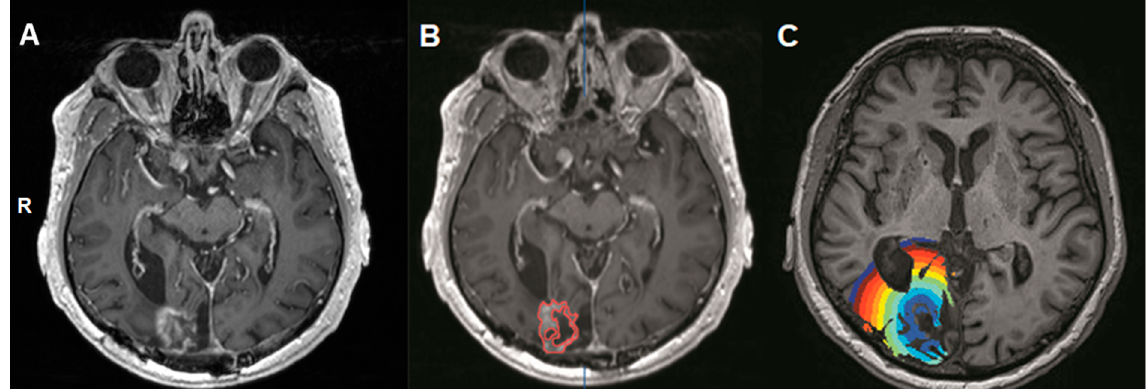
Figure 1. Illustration of the volumes-of-interest (VOIs). A contrast-enhanced axial T1-weighted morphological MRI scan of a patient with a right occipital contrast-enhancing lesion fitting the criteria for radiation necrosis (see methods). The three depicted images represent an axial orientation of T1-weighted volumes showing the right contrast-enhancing occipital lesion ( A ), the intralesional volume-of-interest drawn on the same scan ( B ), and the concentrically expanding 3 mm volumes-of-interest for the analysis of the perilesional tissue ( C ). For illustrative purposes, each volume-of-interest is depicted with a different color (R: right). This analysis was done for the radiation necrosis group and the group with newly diagnosed glioblastoma.